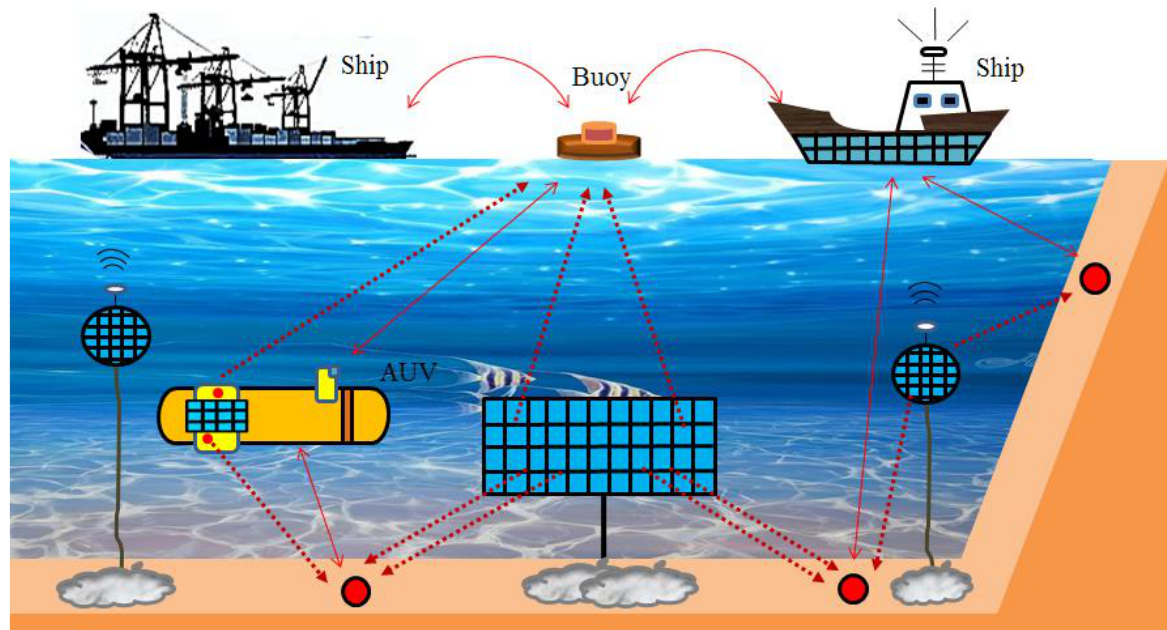
Figure 8. IoUT assisted by intelligent reflecting surfaces.